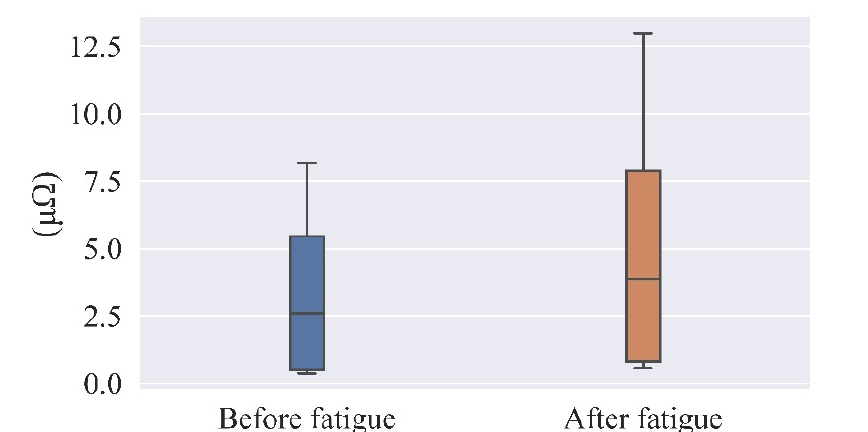
Figure 11. Comparison of mean values of subjects’ skin conductance before and after brain fatigue. The results of the test are shown in Table 11. A paired-samples t -test of the mean electrodermal values before and after the subjects’ brain fatigue induction revealed a significant difference (t = 3.4, p < 0.05) with sustained VDT operations, giving the subjects significantly higher electrodermal values after brain fatigue than before brain fatigue. Table 10. Skin conductance before and after brain fatigue. Table 11. Paired samples t -test results of electrodermal values.